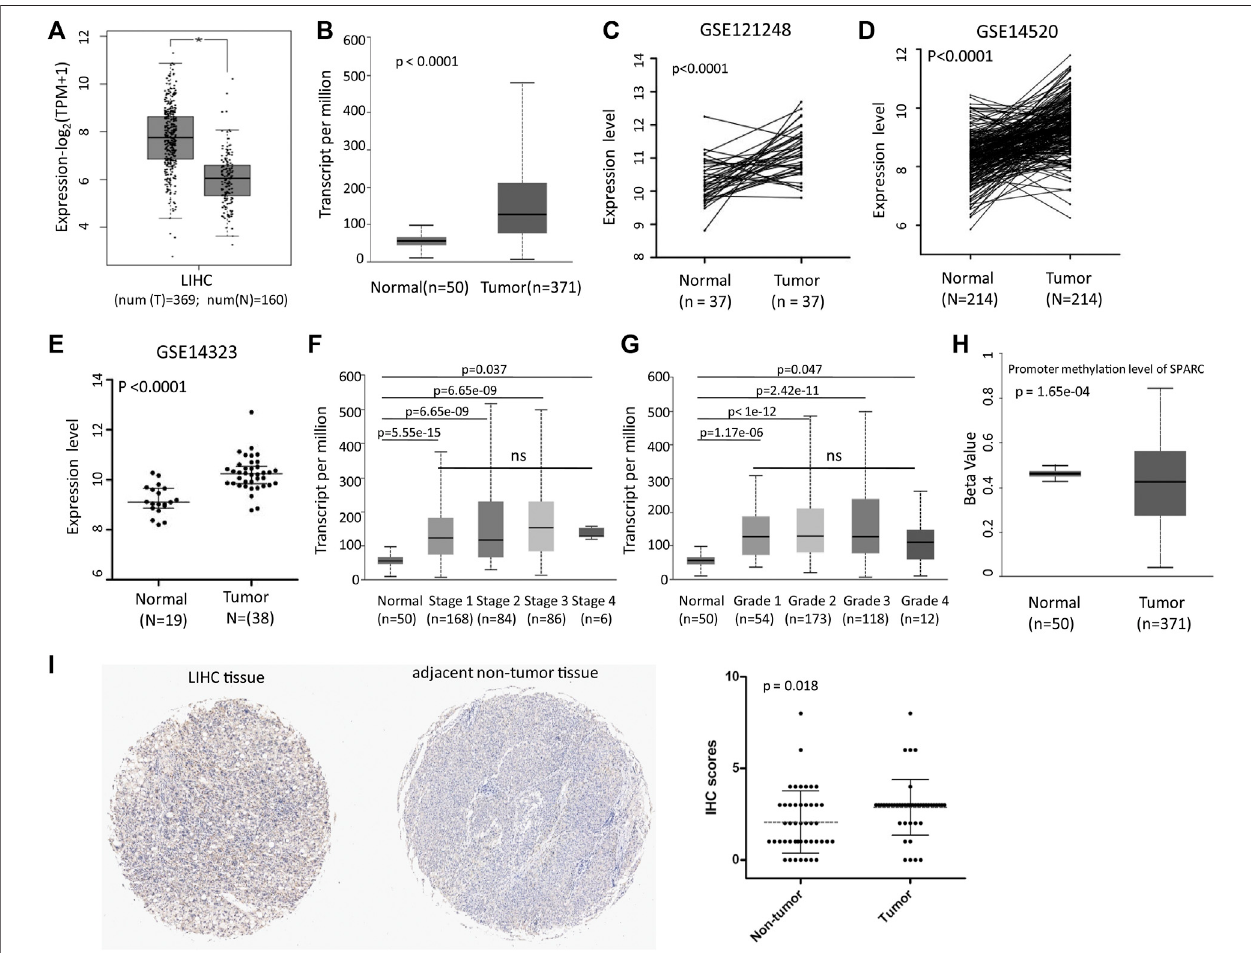
FIGURE 1 | SPARC mRNA expression in LIHC tissues and normal controls. (A) Differential SPARC mRNA expression between the LIHC and normal live tissues in the GEPIA2 database. (B) Differential SPARC mRNA expression between the LIHC and normal controls in the UALCAN database. (C – E) Differential SPARC expression between the LIHC tissues and non-tumor tissues in GSE121248, GSE14520, and GSE14323 datasets. (F, G) Boxplot of SPARC expression based on the tumor stage and grade. (H) Boxplot of SPARC promoter methylation level. (I) IHC analysis of LIHC tissue microarray.